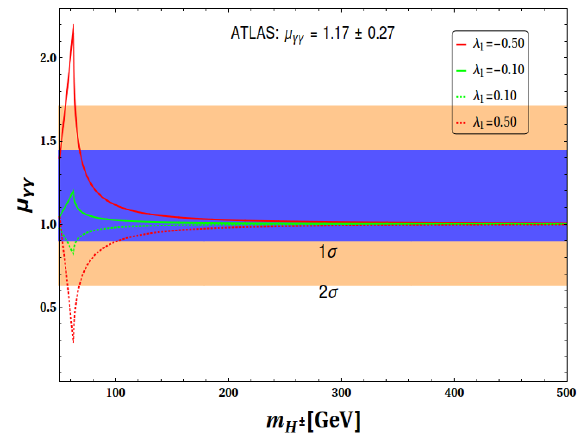
Figure 3 . (cid:22) (cid:13)(cid:13) as function of m for di(cid:11)erent values of (cid:21) 1 as de(cid:12)ned in the inset. 1 (cid:27) and 2 (cid:27) H (cid:6) limits of (cid:22) (cid:13)(cid:13) from ATLAS are also shown in blue and orange colours for comparison purpose. where A represents pure SM contribution (see SM